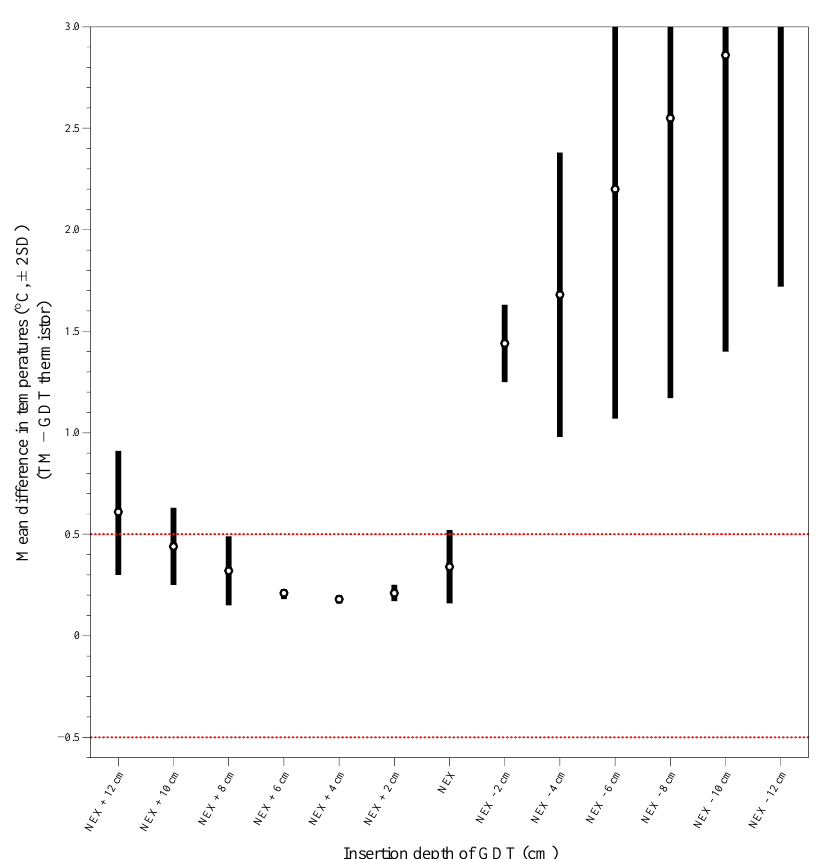
Figure 2. Mean difference ±1.96 standard deviations (SDs) of temperatures between the tympanic membrane and gastric decompression tube (GDT) thermistor. The mean difference ±1.96 SD remained between −0.5 °C and 0.5 °C at the GDT depths within a nose– earlobe – xiphoid distance (NEX) +8 cm to NEX + 2 cm, which was considered a clinically acceptable location. At NEX + 4 cm, the mean differences in temperature were the most minor between the GDT thermistor and TM.